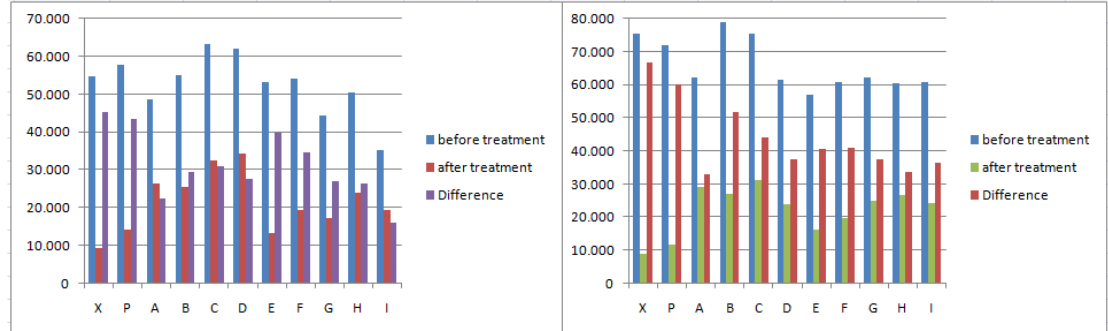
Figure 6. Histograms of the values of ATP measured before and after the treatment and their difference for each zone of Area 1 ( left ) and Area 2 ( right ).